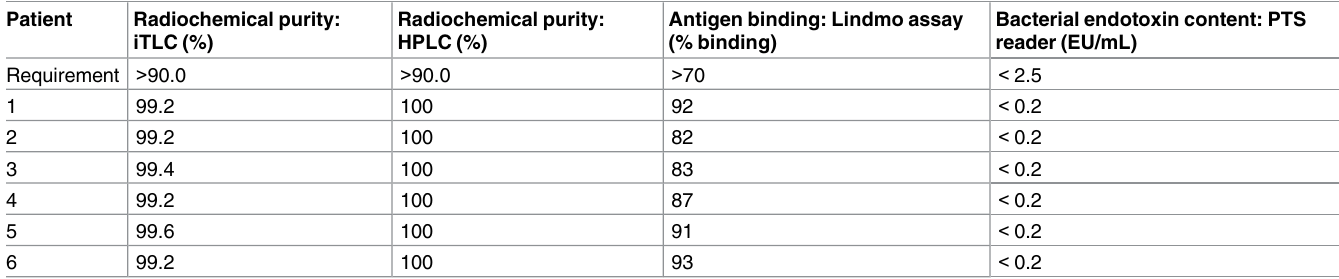
Table 2. Quality controls of 89